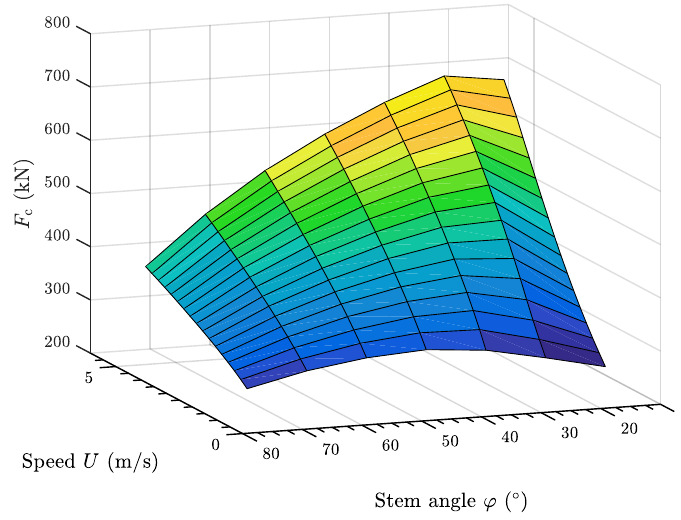
Figure 21. Ship stem collision: ice bending failure force in terms of ship speed and stem angle with ice thickness of 0.32 m.